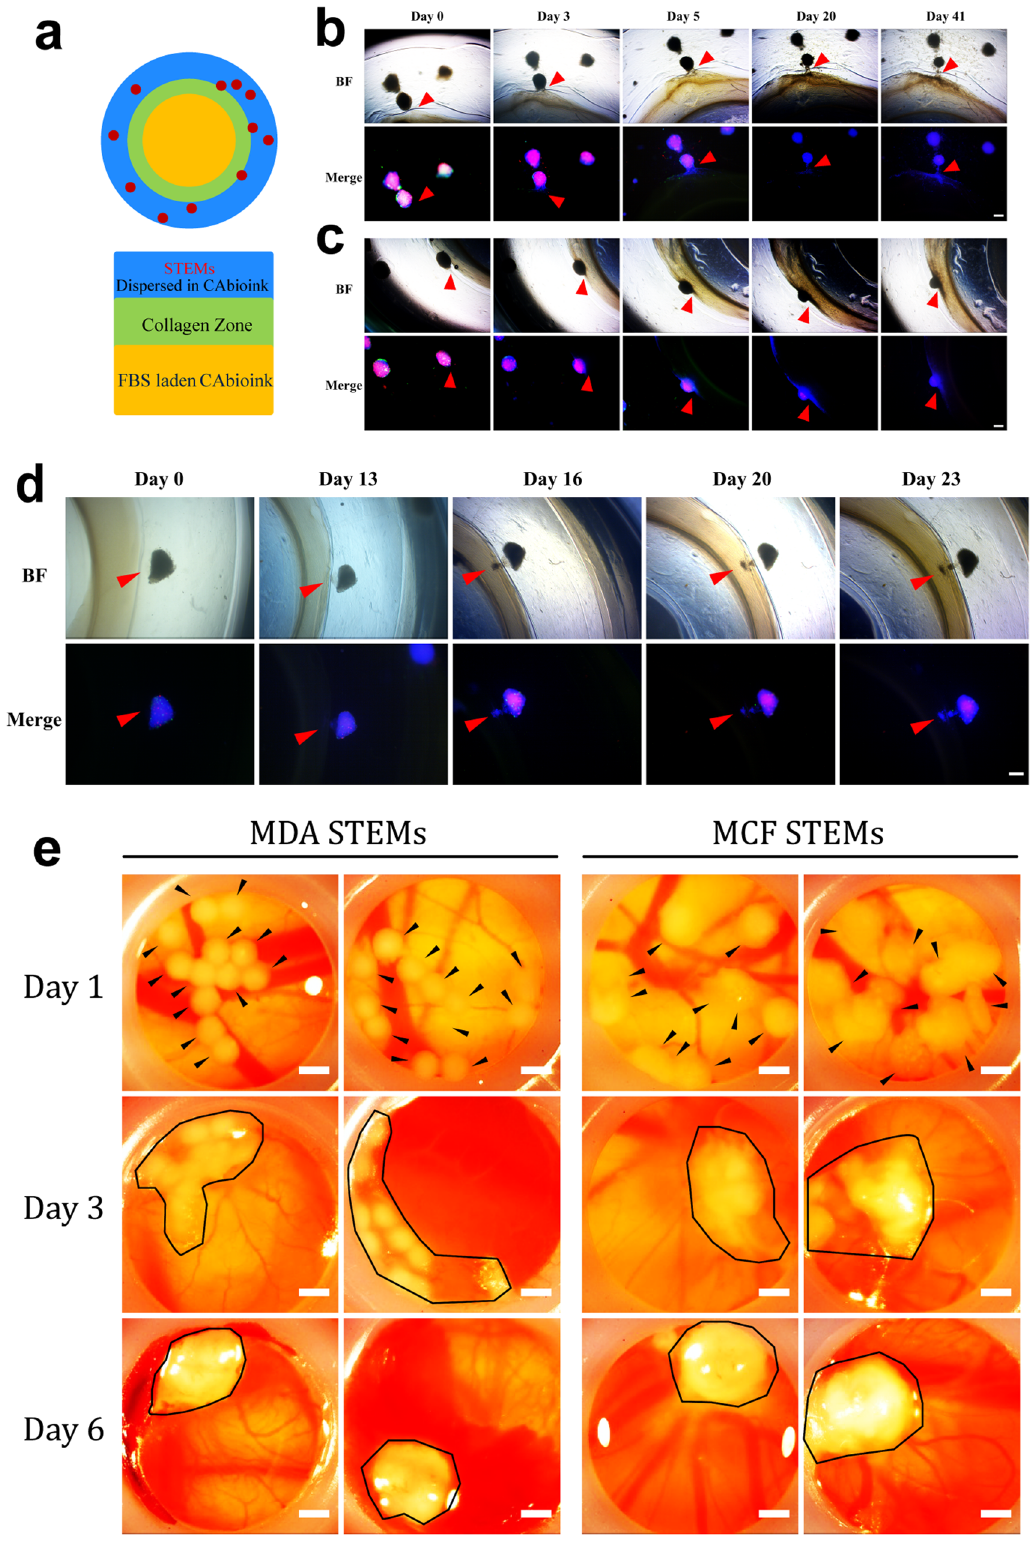
Methods Cell culture and reagents . The human breast cancer cell lines (MDA-MB-231 and MCF-7), the human pancreatic cancer cell lines (Mia Paca-2 and PNAC-1), MCF- 10A, and HEK293 cells were provided by the toolbox of BIOSS (Center for Bio- logical Signaling Studies, University of Freiburg) and were genotyped and veri fi ed by Labor für DNA Analytik (Freiburg, Germany). BT549 cells were kindly pro- vided by DKFZ (Heidelberg, Germany) and were authenticated using Multiplex